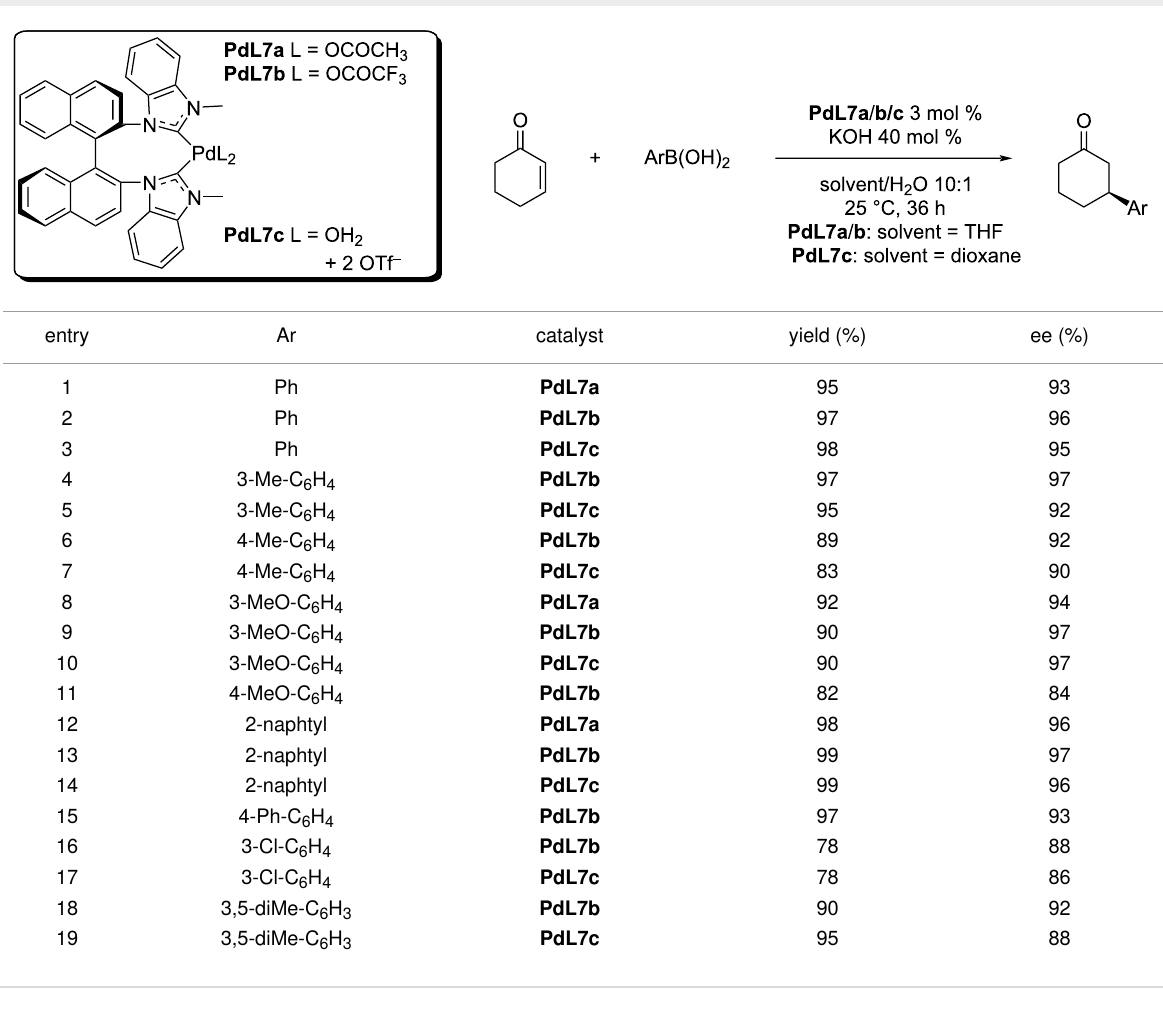
Table 14: Addition reaction of arylboronic acids to different enones catalysed by Pd-NHC complexes PdL7a–c